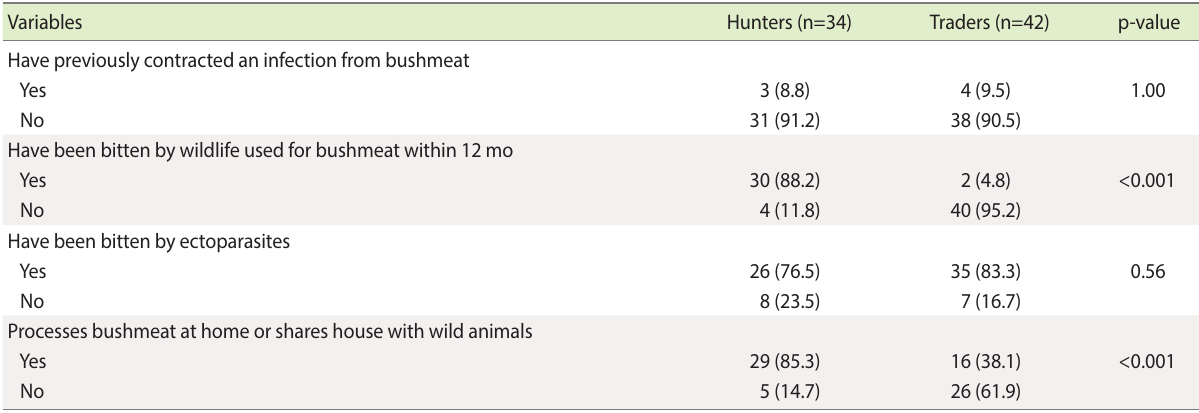
Table 4. Behavioural risk factors for zoonotic infections Variables